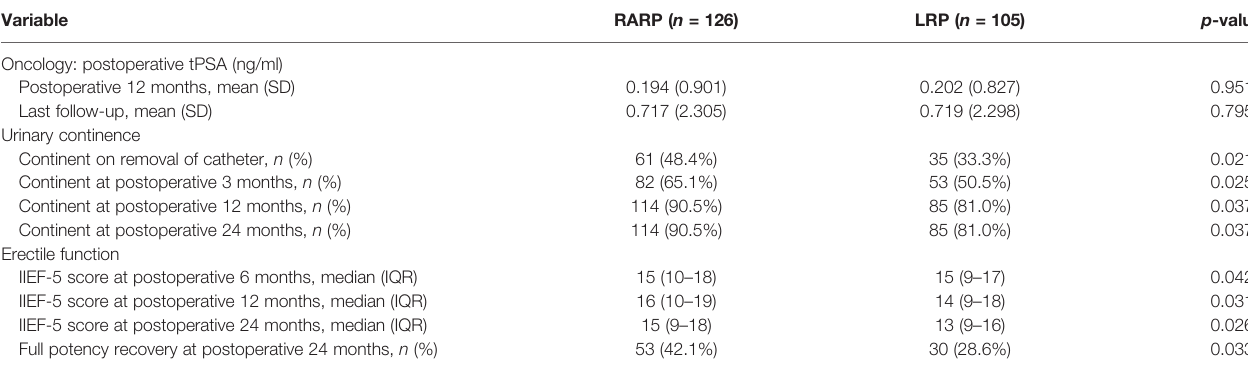
TABLE 3 | Postoperative outcomes following robot-assisted radical prostatectomy (RARP) and laparoscopic radical prostatectomy (LRP). Variable p